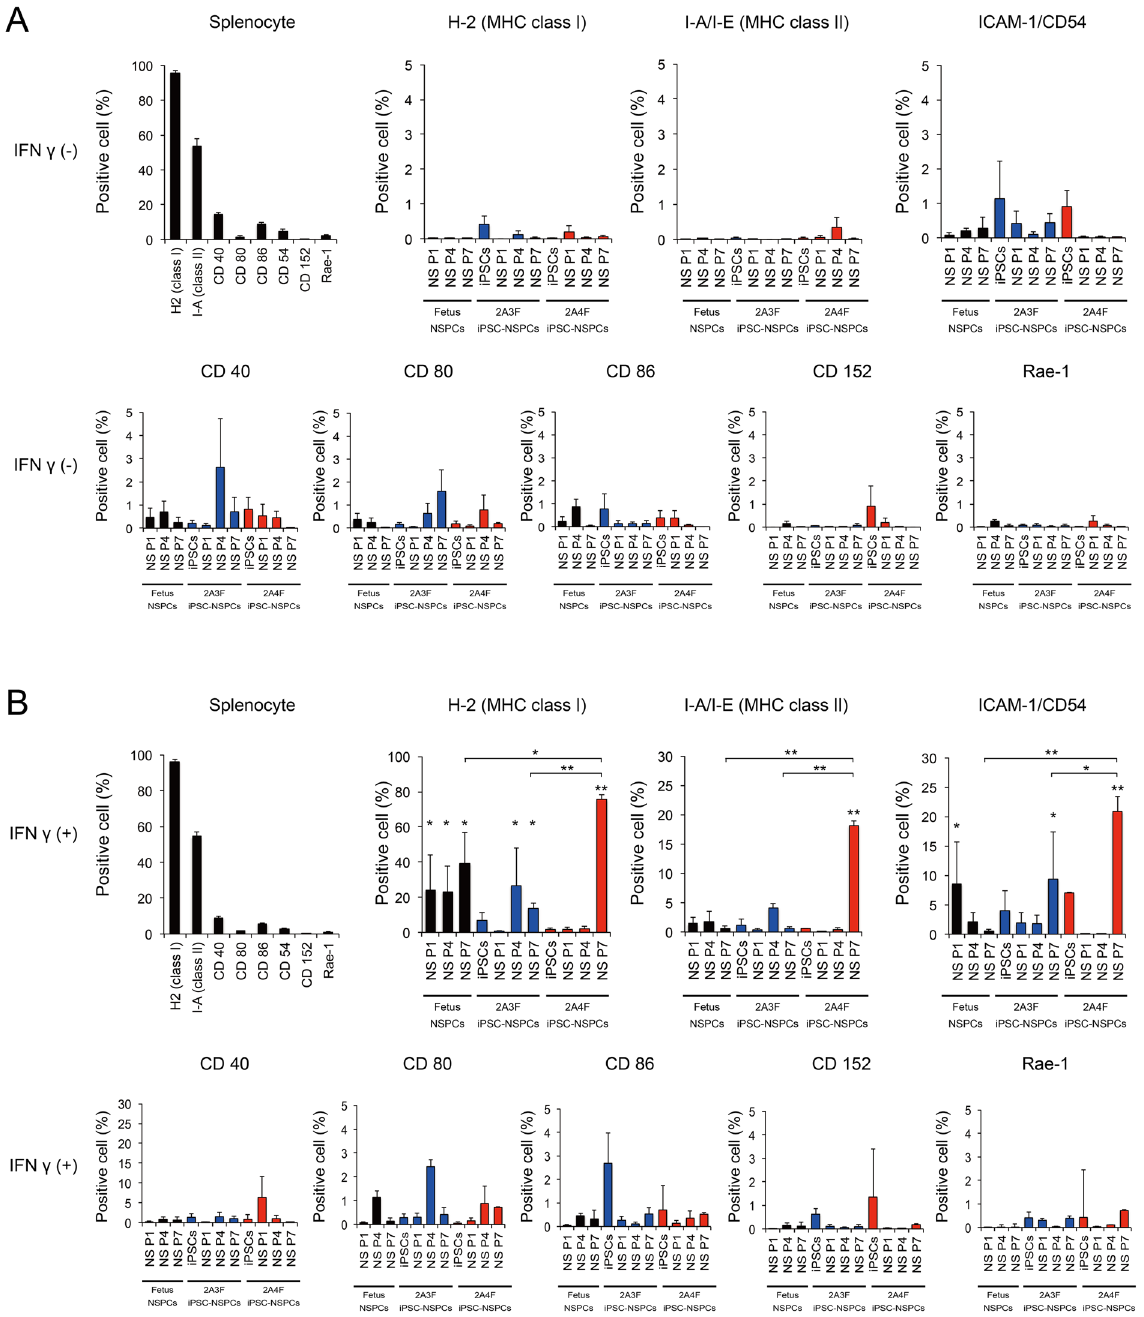
Figure 2. Fetus-NSPCs and iPSC-NSPCs showed a similar low expression level of immune-related proteins. The expression levels of MHC class I (H-2), MHC class II (I-A), ICAM-1 (CD54), co-stimulatory molecules (CD40, CD80, and CD86), CTLA4 (CD152), and NKG2DL (Rae-1) were assessed using flow cytometry in mouse spleen cells, fetus-NSPCs, iPSCs, and iPSC-NSPCs with ( A ) or without ( B ) the addition of IFN γ (n = 3 independent experiments). Values are shown as the mean ± SEM. * P < 0.05 and ** P < 0.005, one-way ANOVA followed by the Tukey–Kramer